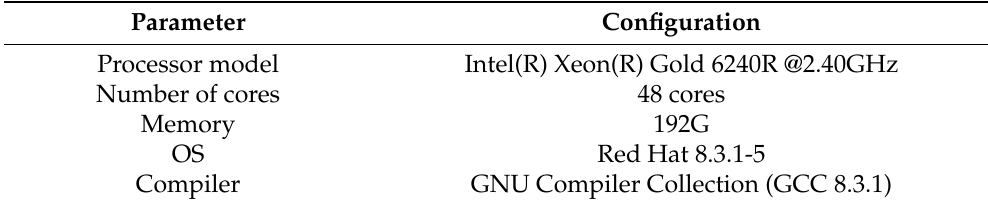
Table 1. The platform configuration used in the study.